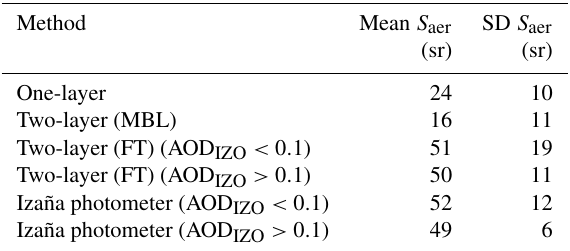
Table 2. Lidar ratio output from the different